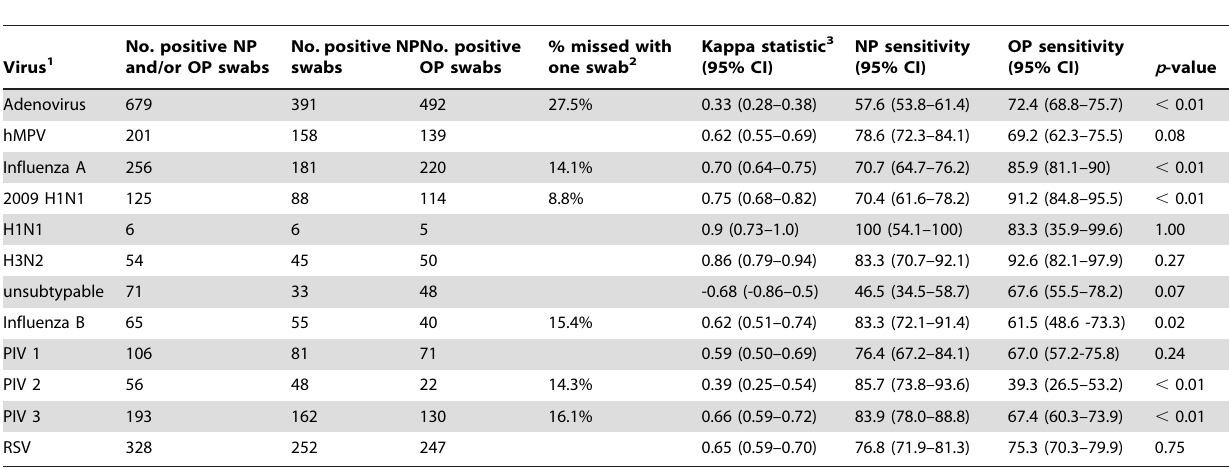
Table 4. Kappa and sensitivity values of paired nasopharyngeal (NP) swabs and oropharyngeal (OP) swabs for respiratory viruses in all patients (n=2331) – Kenya,